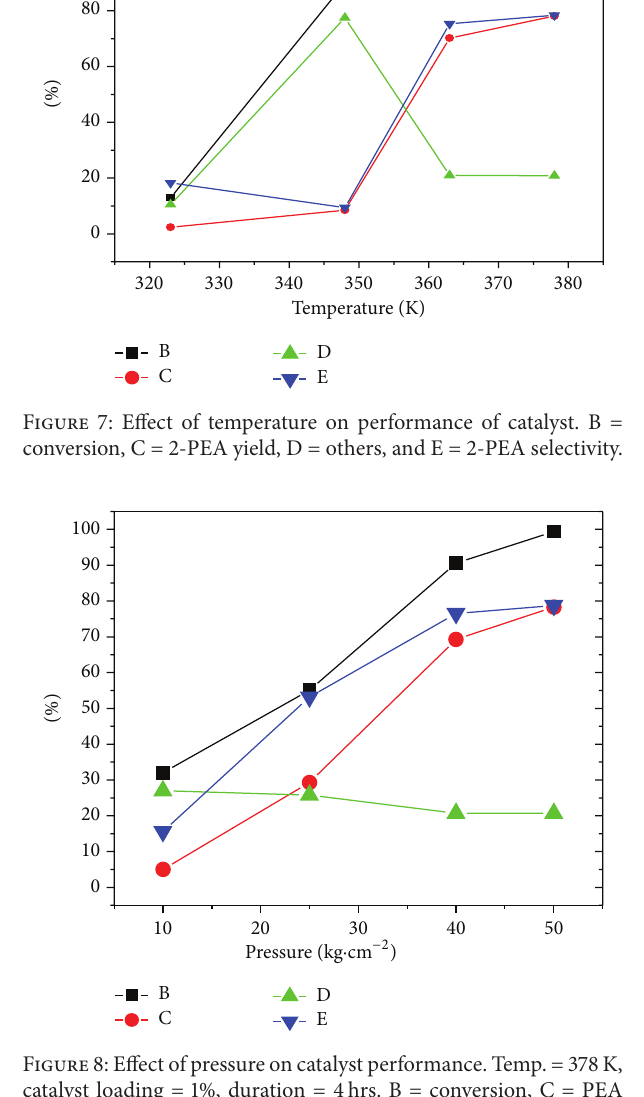
Figure 6: Effect of catalyst loading on the performance of the catalyst. B = conversion, C = 2-PEA yield, D = others, and E = 2- PEA selectivity.